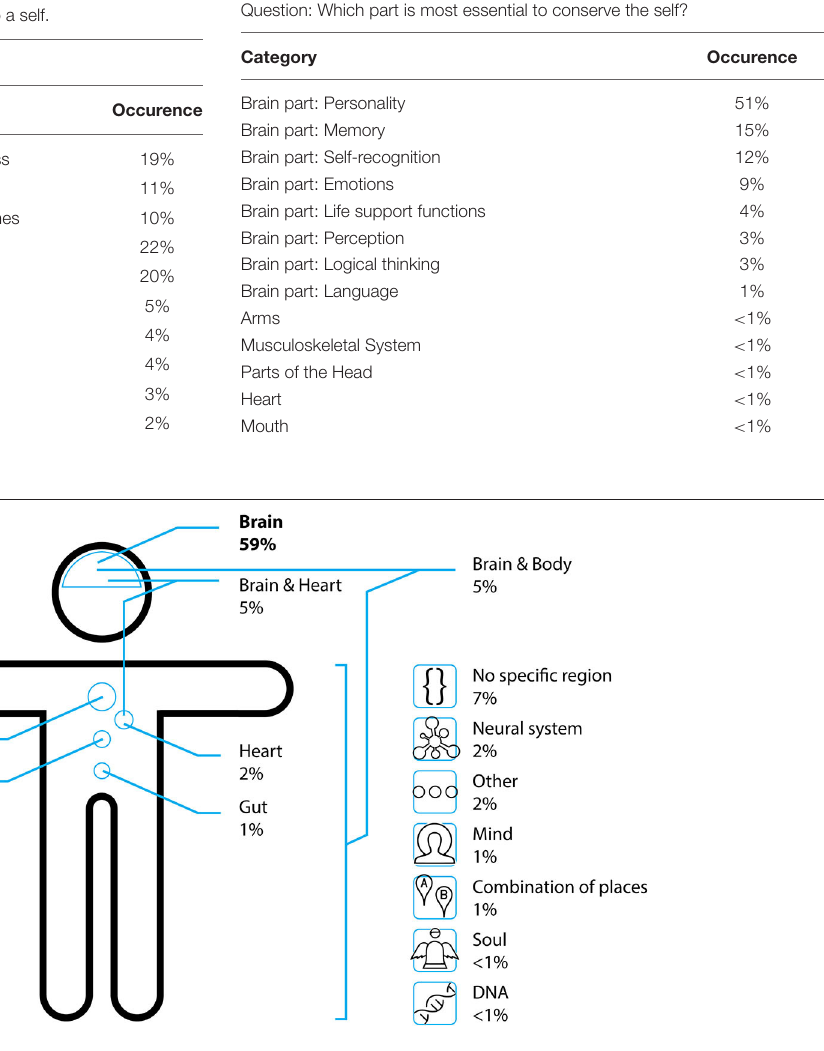
FIGURE 4 | The participants’ assumptions about the physical location of the self.